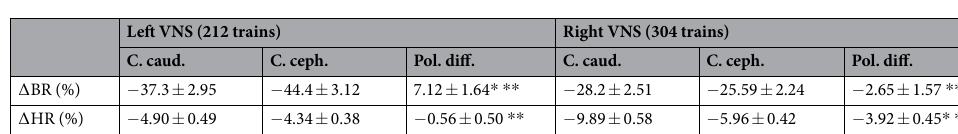
the placement of the recording electrode, a drop in fiber activation magnitude with increasing intensity in the cathode cephalad polarity would be consistent with anodal block, with the caudal stimulating electrode acting as anode. Visible stimulus-evoked compound nerve action potentials (sCNAPs) were elicited at intensities of 20 ± 6.23 μ A and 10 ± 3.70 μ A, for 100 μ s and 1000 μ s pulse widths, respectively. When pulse width was short (100 μ s), stimulus-evoked for the 2 polarities were similar (Fig. 4a,b). A- and B-type fiber response magnitudes were com- parable across different current intensities and both A- and B-type fiber responses increased with increasing